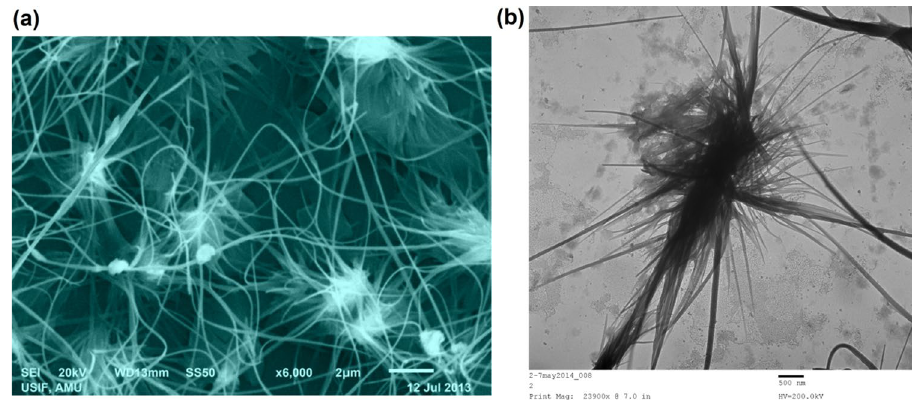
Figure 2. ( a ) SEM image and ( b ) TEM image of as synthesized ZNsw via sol–gel